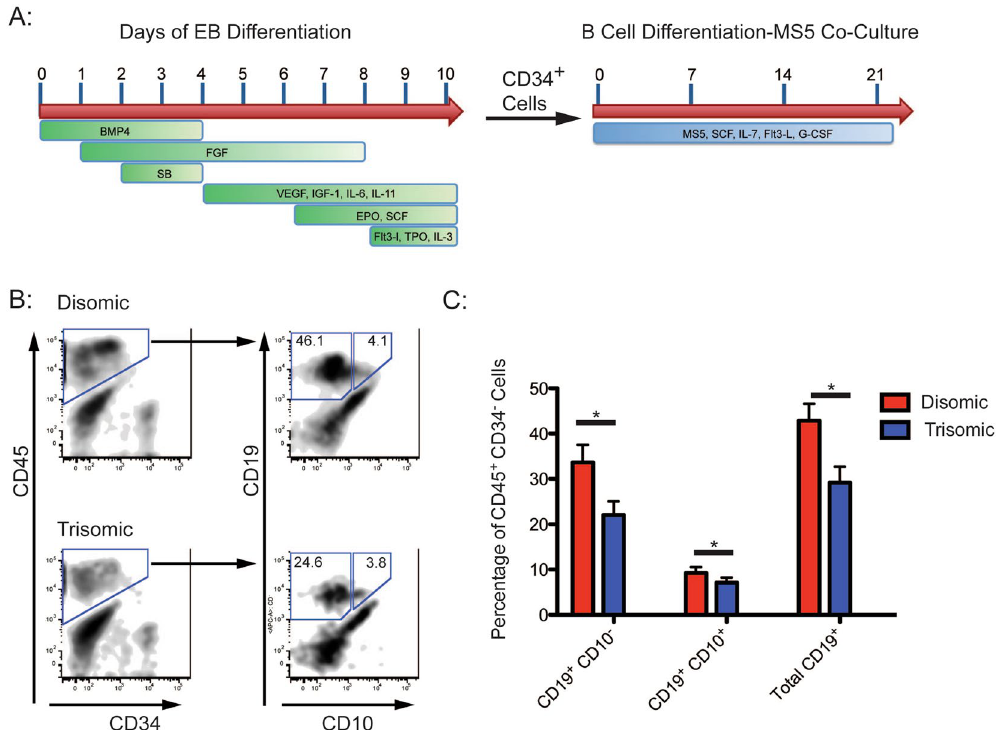
Figure 1. Trisomy 21 Pluripotent Cells Exhibit a Reduced Capacity for B Cell Differentiation. ( A ) Schematic of culture conditions for B Cell differentiation of human pluripotent cells. ( B ) Representative FACS plots of differentiated disomic and trisomic isogenic iPS cells. Plots show the distribution of CD19 + CD10 + cells within gated CD45 + CD34 − cells. ( C ) Quantification of FACS analysis, shown as percentage of CD19 + and CD10 + cells within CD45 + CD34 − populations. Trisomic clones (N = 22) generated fewer CD19 + and CD19 + CD10 + cells than disomic (N = 22) counterparts. ( * p-value ≤